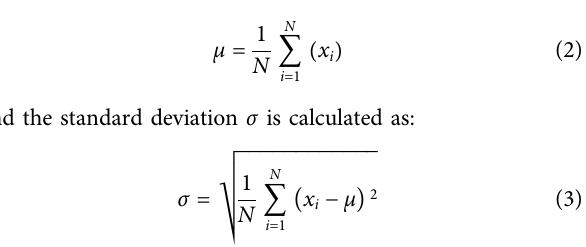
Frontiers in Energy Research |